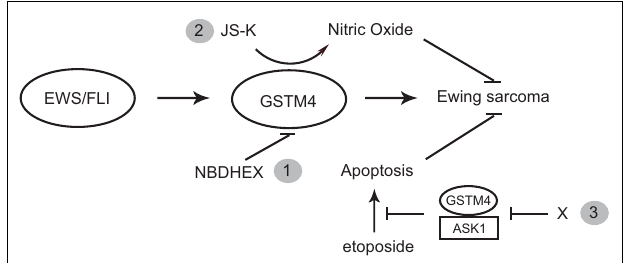
FIGURE 5 | GSTM4 is a potential therapeutic target for Ewing sarcoma . GSTM4 is an EWS/FLI-target gene that functionally contributes to the cancer phenotype of Ewing sarcoma by stimulating oncogenic transformation and increasing resistance to chemotherapeutic agents. Modulation of GSTM4 activity through a variety of approaches may offer more effective treatment options for Ewing sarcoma. Inhibition of GSTM4 by inhibitors (e.g., NBDHEX) may decrease transformation and increase the efficacy of chemotherapeutic drugs (1). GSTM4 pro-drugs such as JS-K can be activated in high GSTM4-expressing tumors, leading to localized nitric oxide release and induction of apoptosis (2). Agents that interrupt GSTM4/ASK1 interaction may increase apoptosis induced by chemotherapeutic drugs, facilitating their ability to limit tumor growth